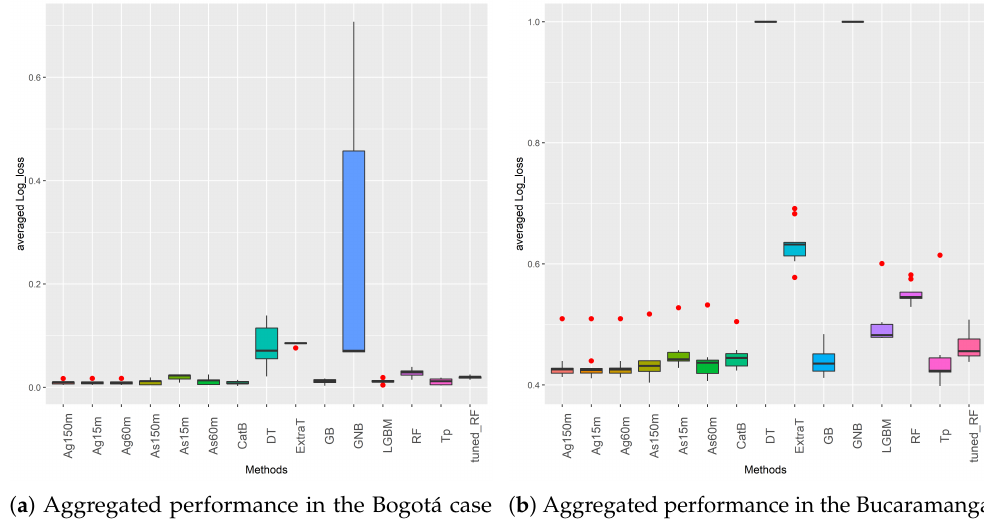
Figure 7. Aggregated log_loss results of ML and AutoML methods in the Bogotá and Bucaramanga multiclass